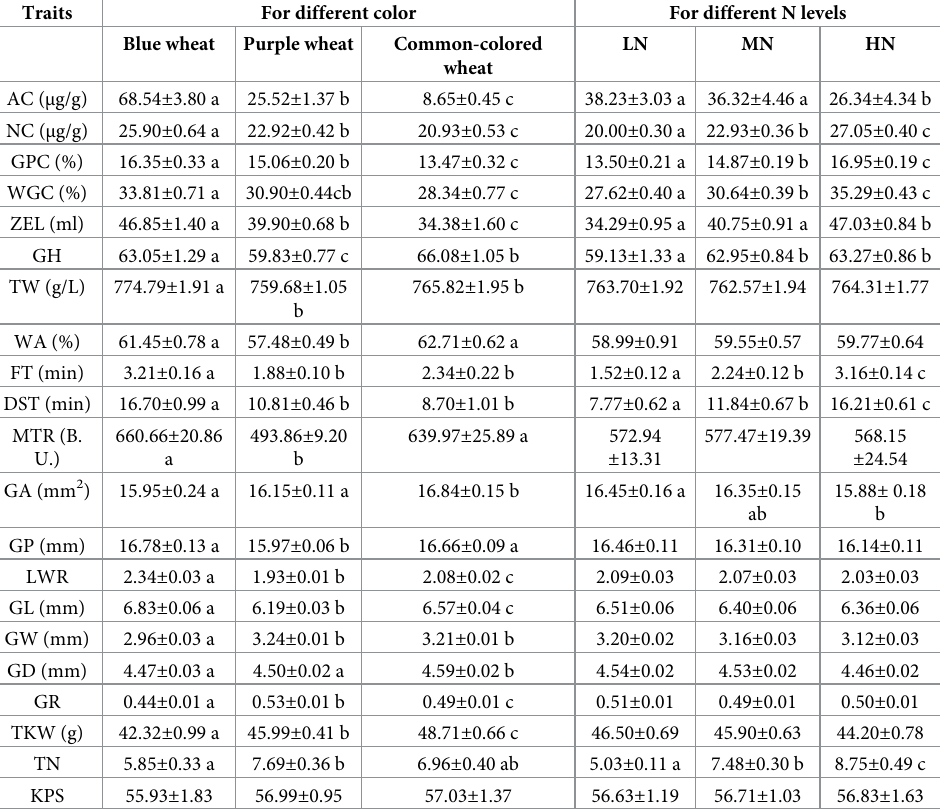
Different letters followed the numbers represent the significant difference among different colored wheat lines or different N levels, P <